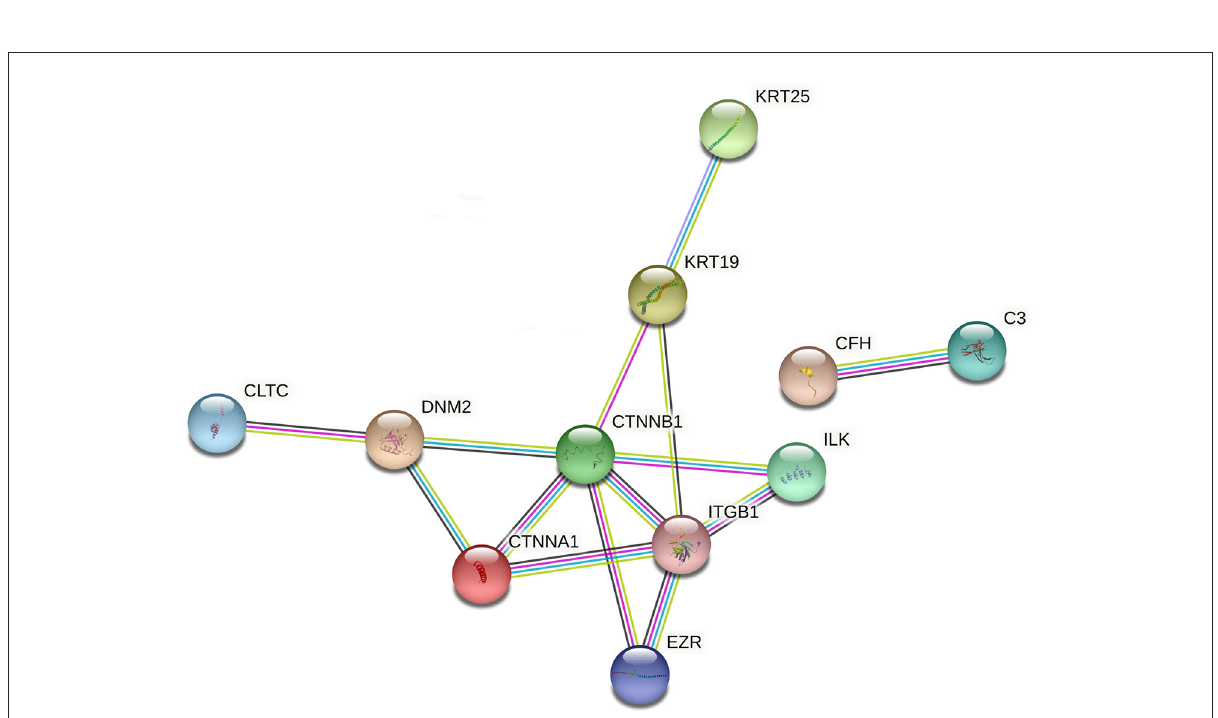
FIGURE5 The PPI networks of differentially expressed proteins (species: bovine) related to bacterial infection. The darkturquoise and pink lines represented the interactions that were identified from curated databases and experimentally determined, respectively. The green, red, and blue lines represented the predicted interactions based on gene neighborhood, gene fusions, and gene co-occurrence relationships, respectively. The yellow-green, black, and purple lines denoted the potential interactions that were identified by textmining, co-expression, and protein homology. The full names of proteins in this figure were shown as follows: C3, complement C3; CFH, complement factor H, KRT19, keratin, type I cytoskeletal 19; KRT25, keratin, type I cytoskeletal 25; DNM2: dynamin-2; ILK: integrin-linked protein kinase; CLTC, clathrin heavy chain 1; CTNNA1, catenin alpha-1; ITGB1, integrin beta-1; CTNNB1, catenin beta-1; BCAM, basal cell adhesion molecule; TUBA4A, tubulin alpha-4A chain; EZR,